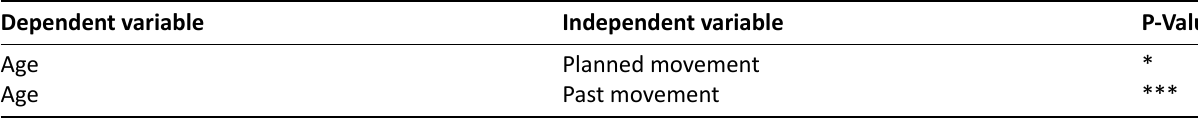
Table 2. Results of the analysis of variance (ANOVA).